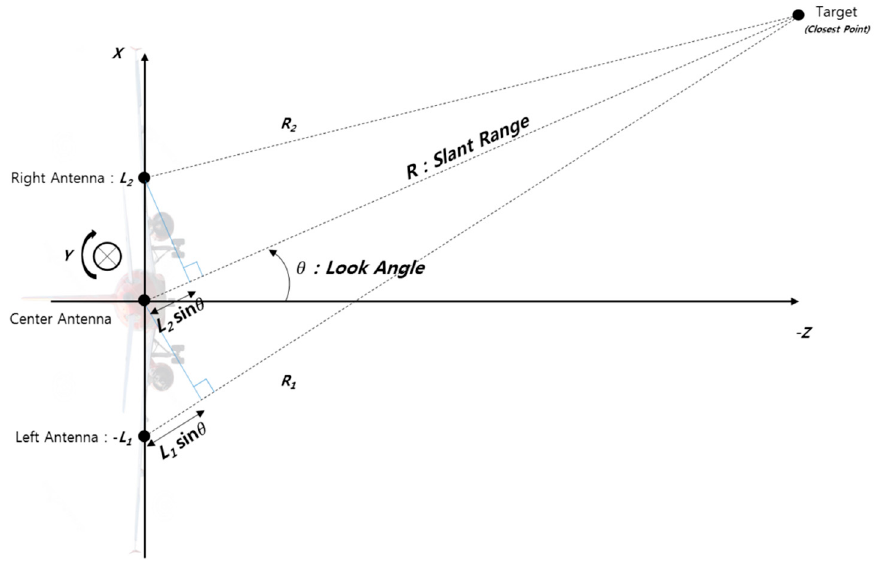
Figure 11. Look angle measurement of IRA [12].